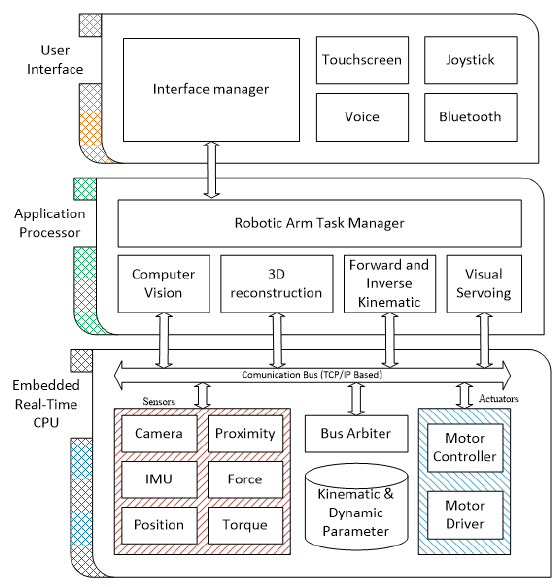
Figure 4. ROS based